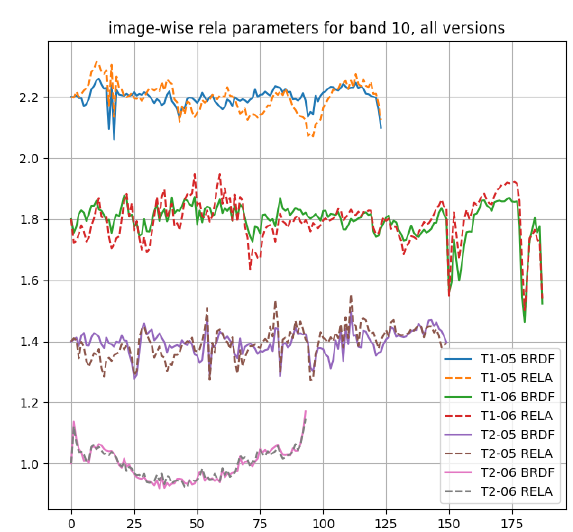
Figure 4. Image-wise relative parameter a , all processing versions. Plots for T2 spring, T1 summer and T1 spring are sifted by 0.4, 0.8 and 1.2 respectively. X-axis is image number for each block.